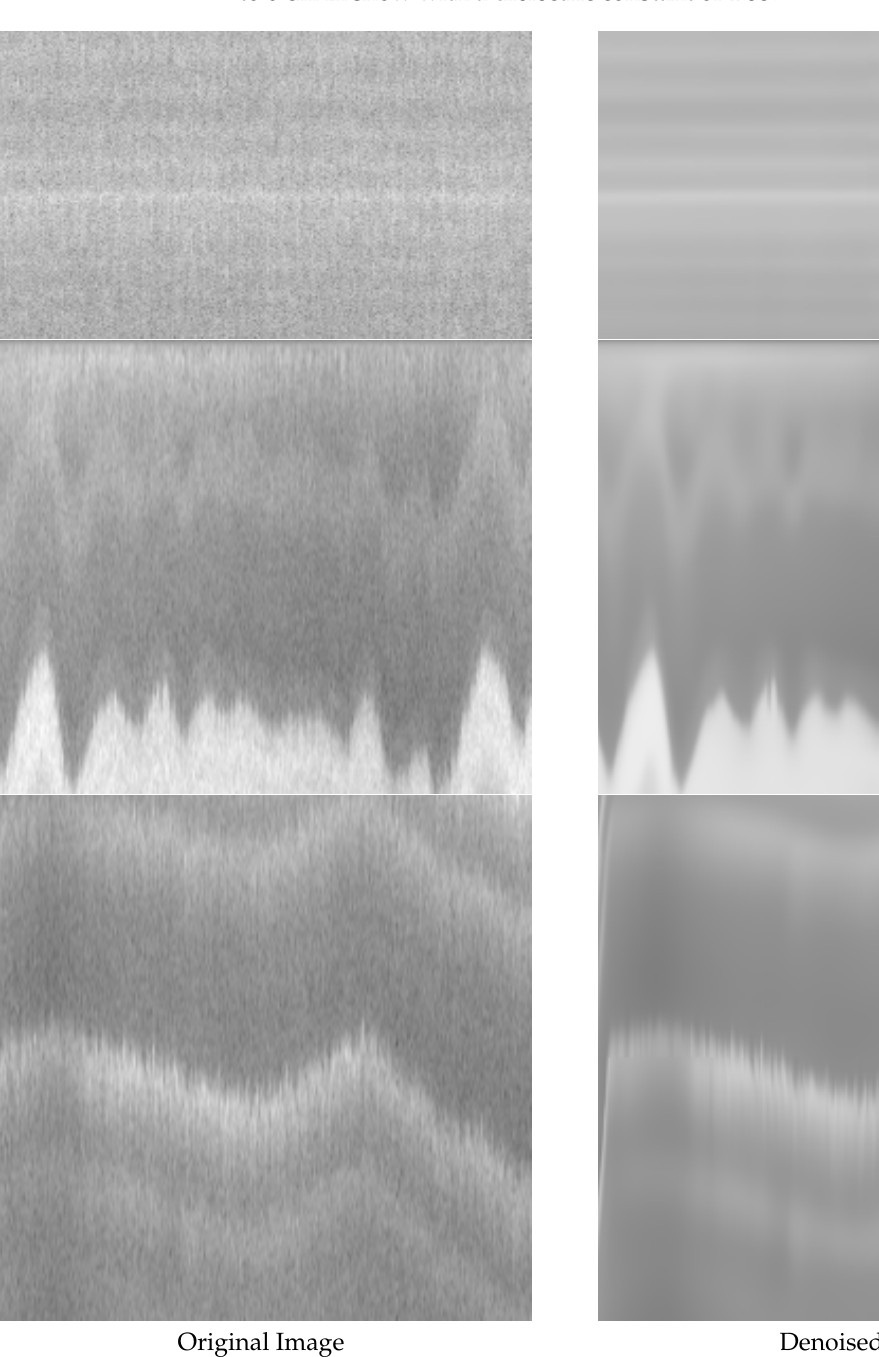
Figure 10. Some sample radar images on the left, and their denoised images on the right. Each radar image is from different years within EG or SG, and has a different